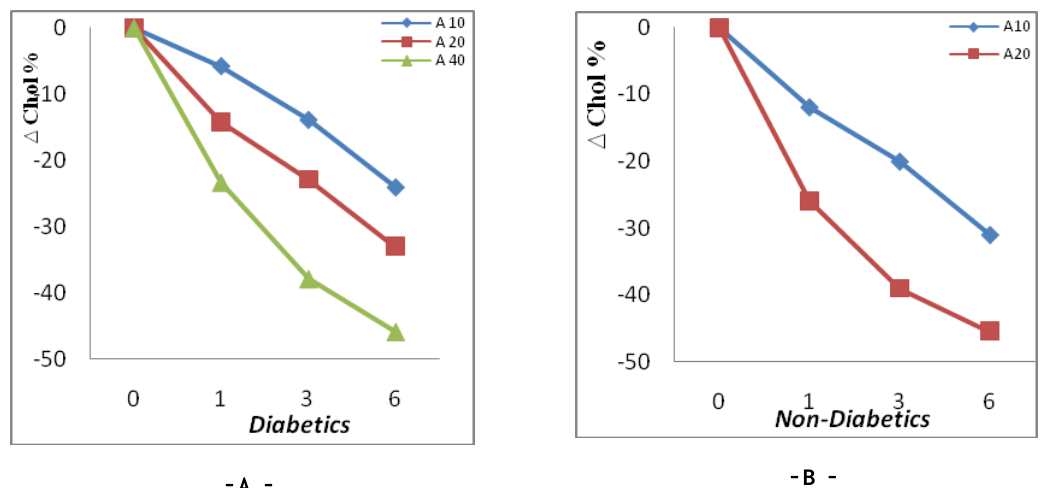
Figure 1 :Line chart showing percentage of serum cholesterol changes after treatment with atorvastatin in diabetics(A) & non-diabetics(B)